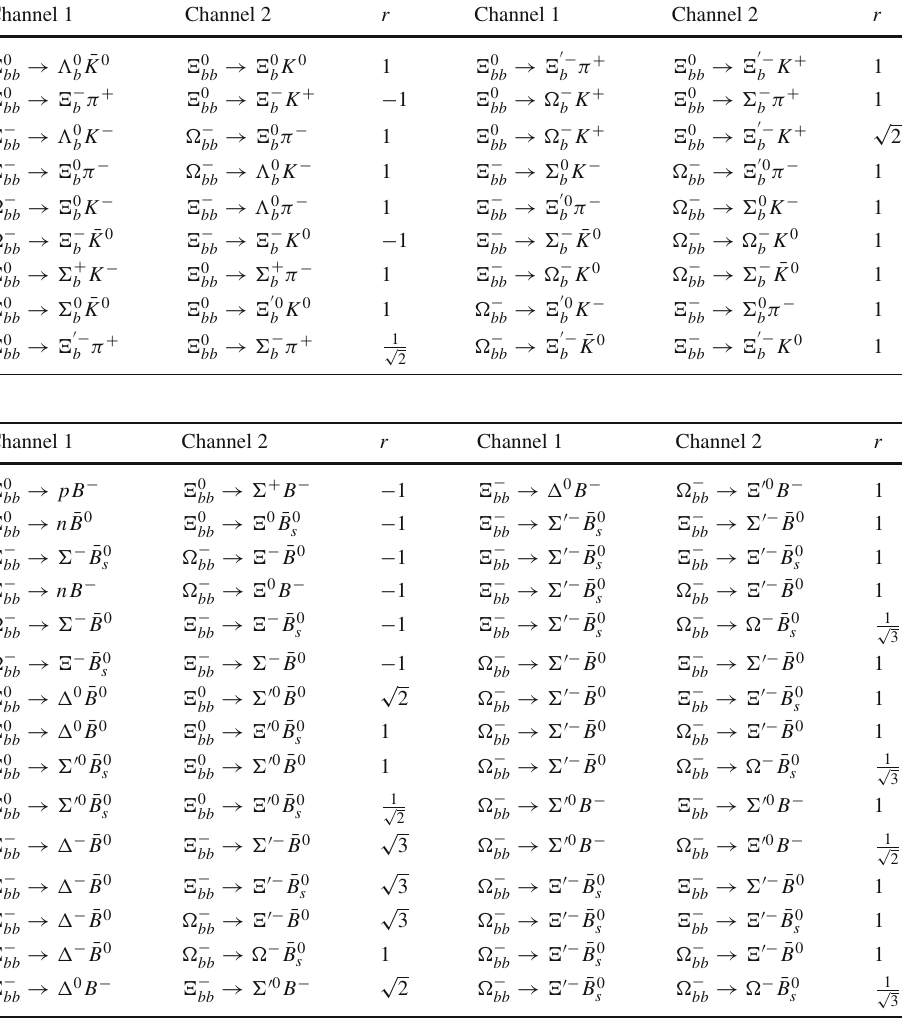
Channel 1 Channel 2